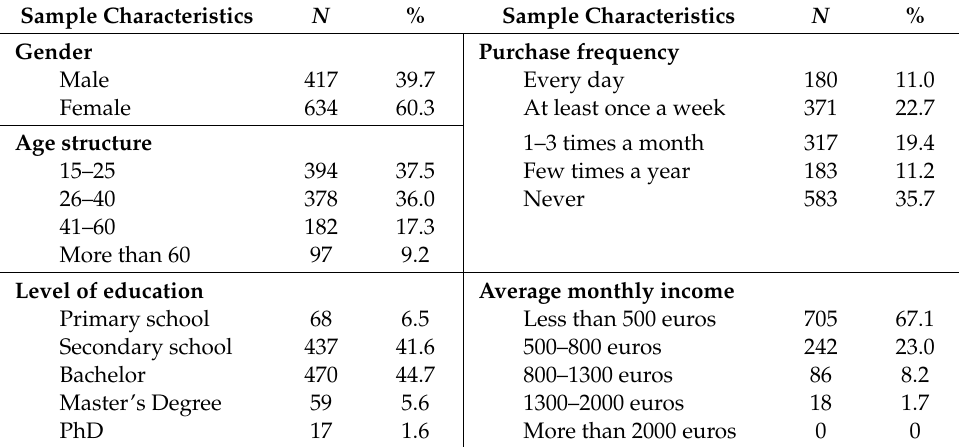
Table 1. An overview of the respondents’ characteristics.